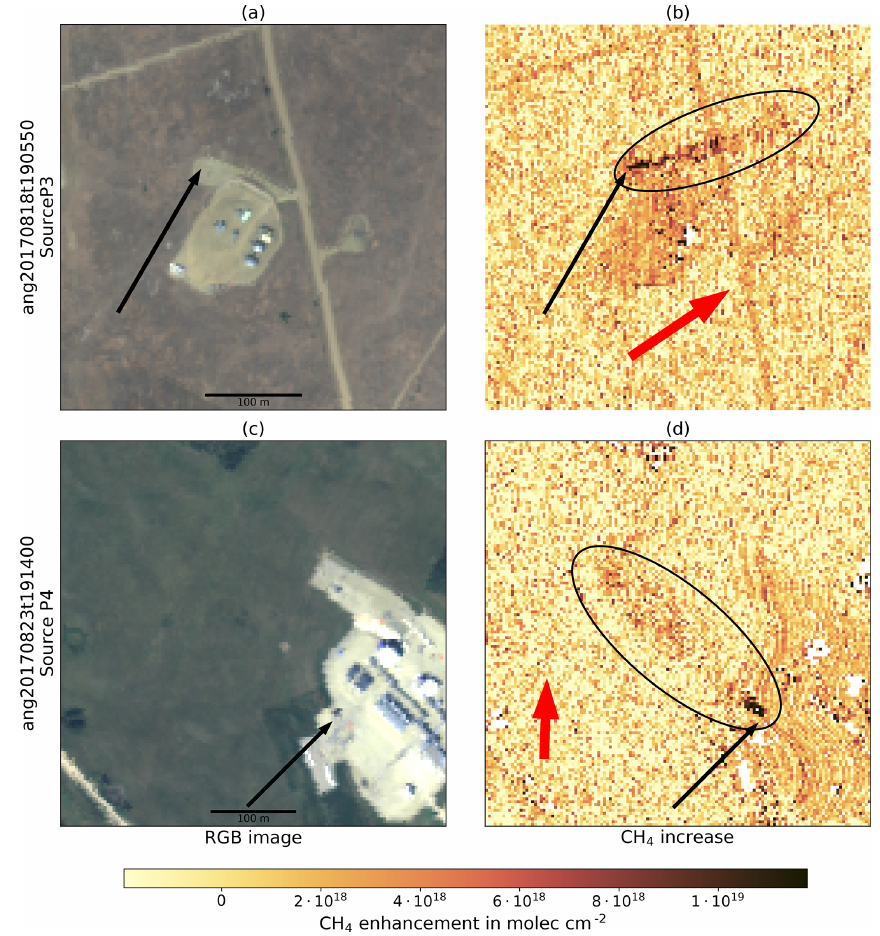
Figure 9. Two additional plumes detected in the retrieval results, emanating from well pads. On the left (a, c) , the RGB images obtained from radiances of AVIRIS-NG are shown. On the right (b, d) , the according retrieval results are presented. The ellipse highlights the plumes. Additionally, the black arrows point to the source of the plumes, while the red arrow indicates the wind direction and wind speed according to ERA-5 data for comparison with the plume direction. The sources are located near grassland.